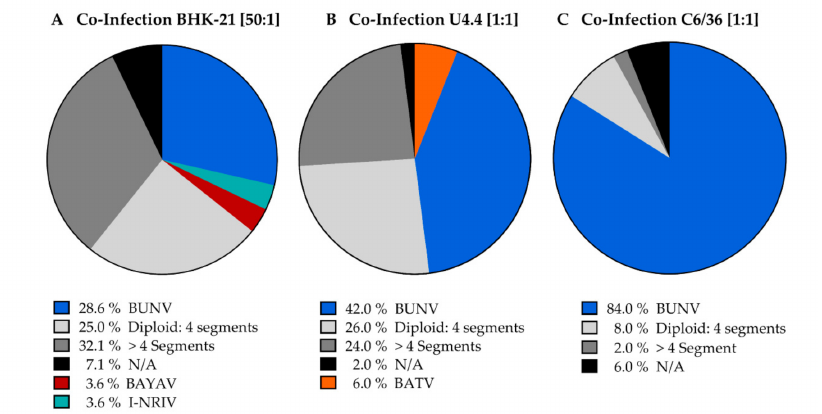
Figure 2. The fraction of total results from co-infection experiments. ( A ) Displays the results from co-infection of BHK-21 cells with Batai orthobunyavirus (BATV) and Bunyamwera orthobunyavirus (BUNV), ( n = 28). Single plaque isolation revealed two direct reassortment events. One isolate, named I - NRIV, is a BUNV reassortant that integrated the BATV M-segment. The second isolate was named BAYAV; it is a BATV reassortant that integrated the BUNV L-segment. ( B ) Shows the results for co-infection in U4.4 insect cells ( n = 50). ( C ) Shows the results after co-infecting C6/36 cells ( n = 50). Isolates that were RT-PCR positive for more than four segments are given as >4 segments, and N/A specifies samples where detection by RT-PCR